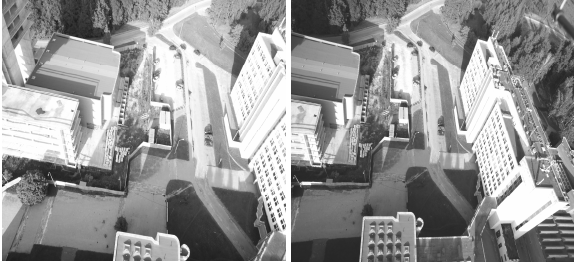
Figure 6. Fragment of results from exterior image orientation – Close Range Photogrammetry Creation of DTMs via image matching (from about 12 000 matched points) and orthophoto generation has been executed using images from both approaches. Figure 7 demonstrates fragment of created orthophoto with representation of